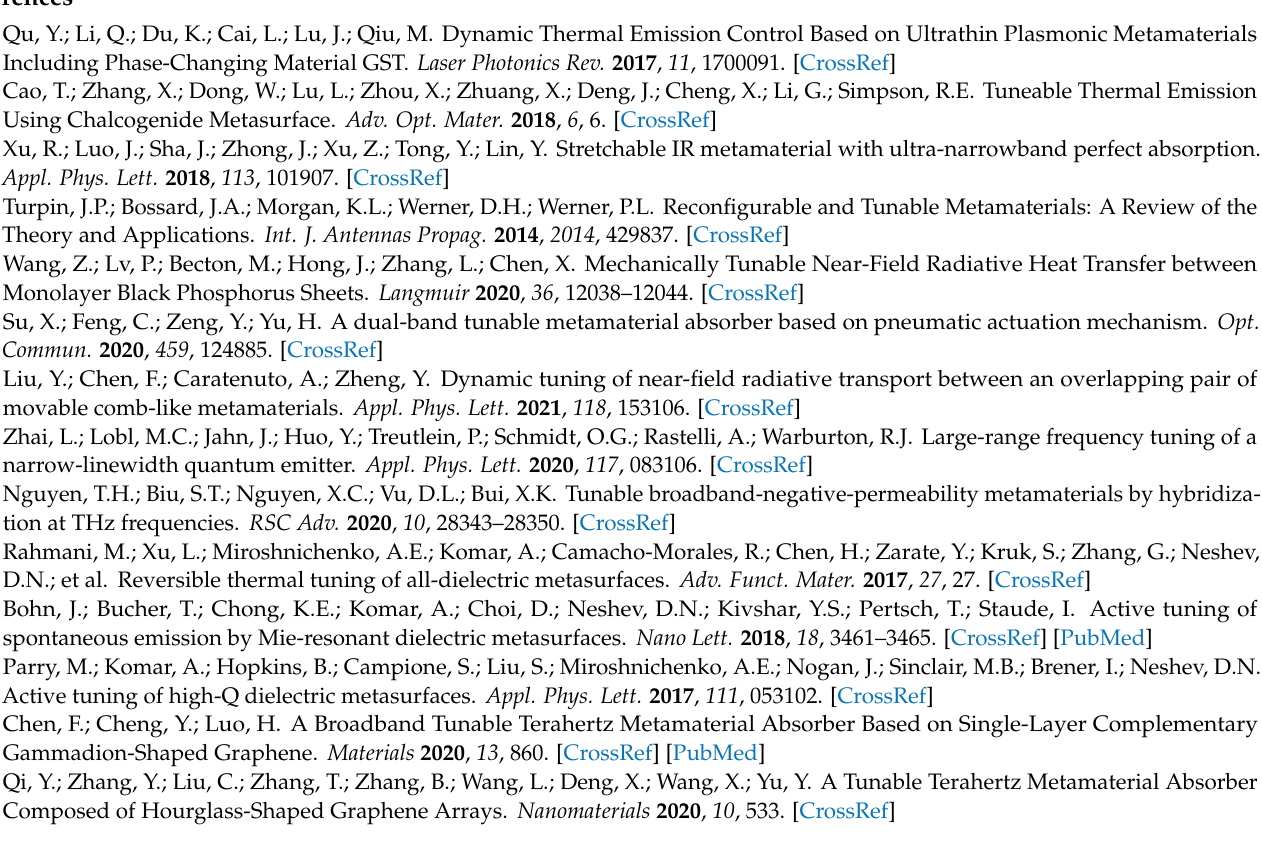
bility data; Figure S3: Schematic of experimental setup for spectra measurements at various angles of